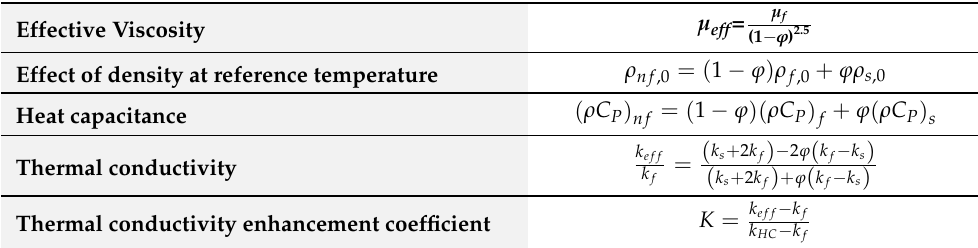
Table 2. Thermophysical properties employed in the Tiwari and Das model. Effective Viscosity µ eff